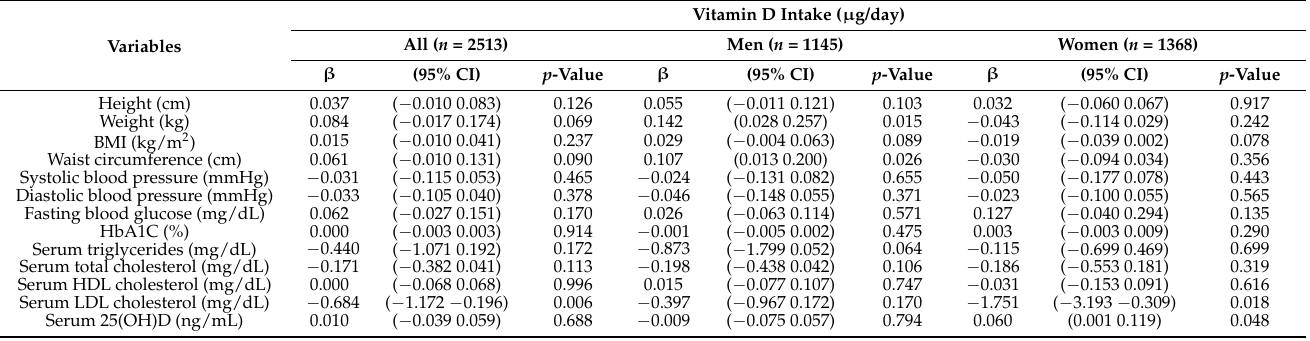
Table 5. Relationship between anthropometric/biochemical measurements and vitamin D intake of